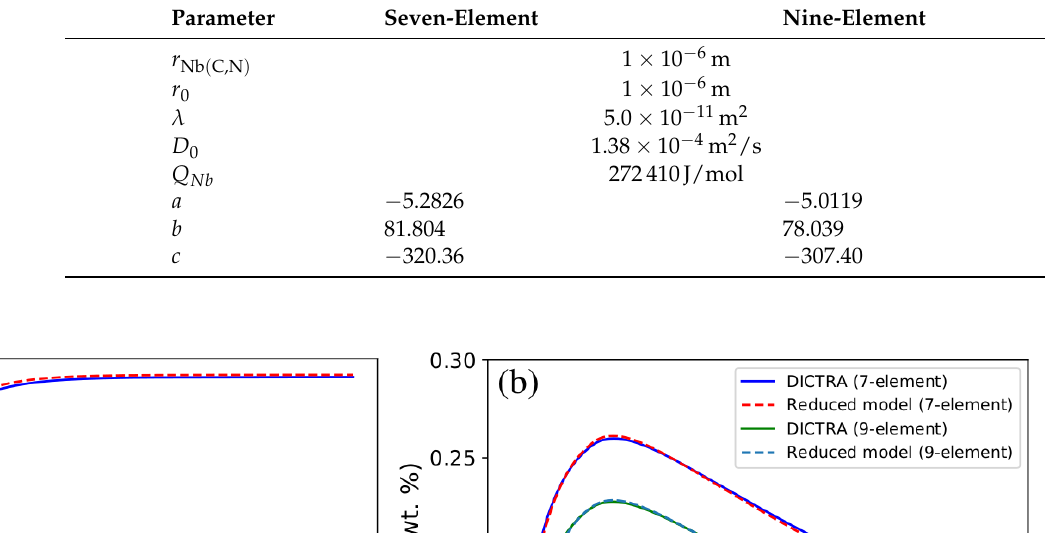
Table 5. Parameters used in the reduced model for themokinetic simulations of Nb(C,N) evolution in austenite (7- and 9-element simulations using the TCFE9 database).